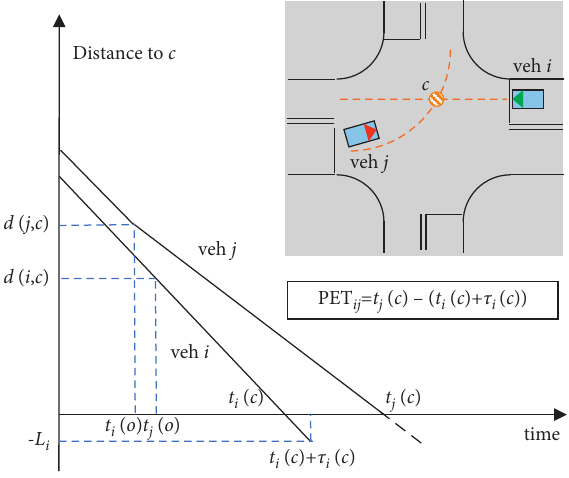
Figure 5: Traffic conflict diagram for